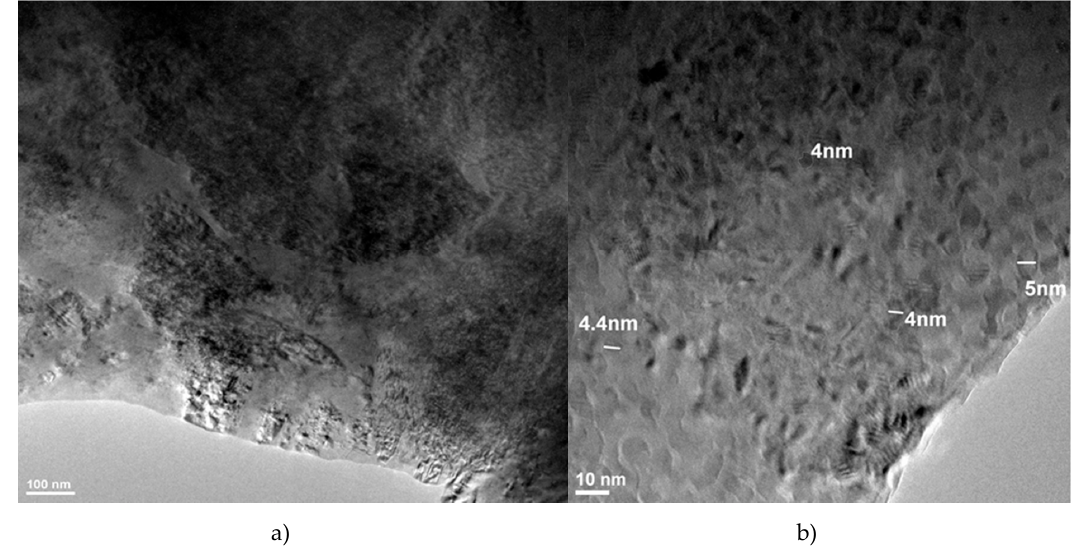
Figure 10. TEM images of Cu-15%Fe 3 O 4 sintered at 800 °C showing the distribution ( a ) and an agglomeration of Fe 3 O 4 nanoparticles embedded into the Cu matrix ( b ).